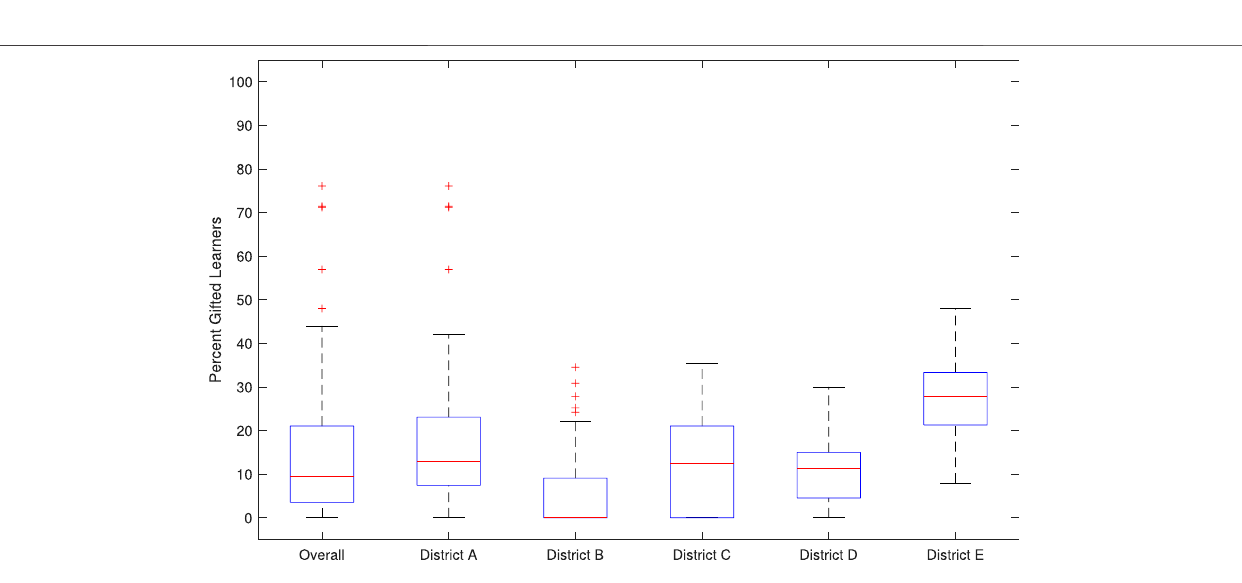
Frontiers in Built Environment |